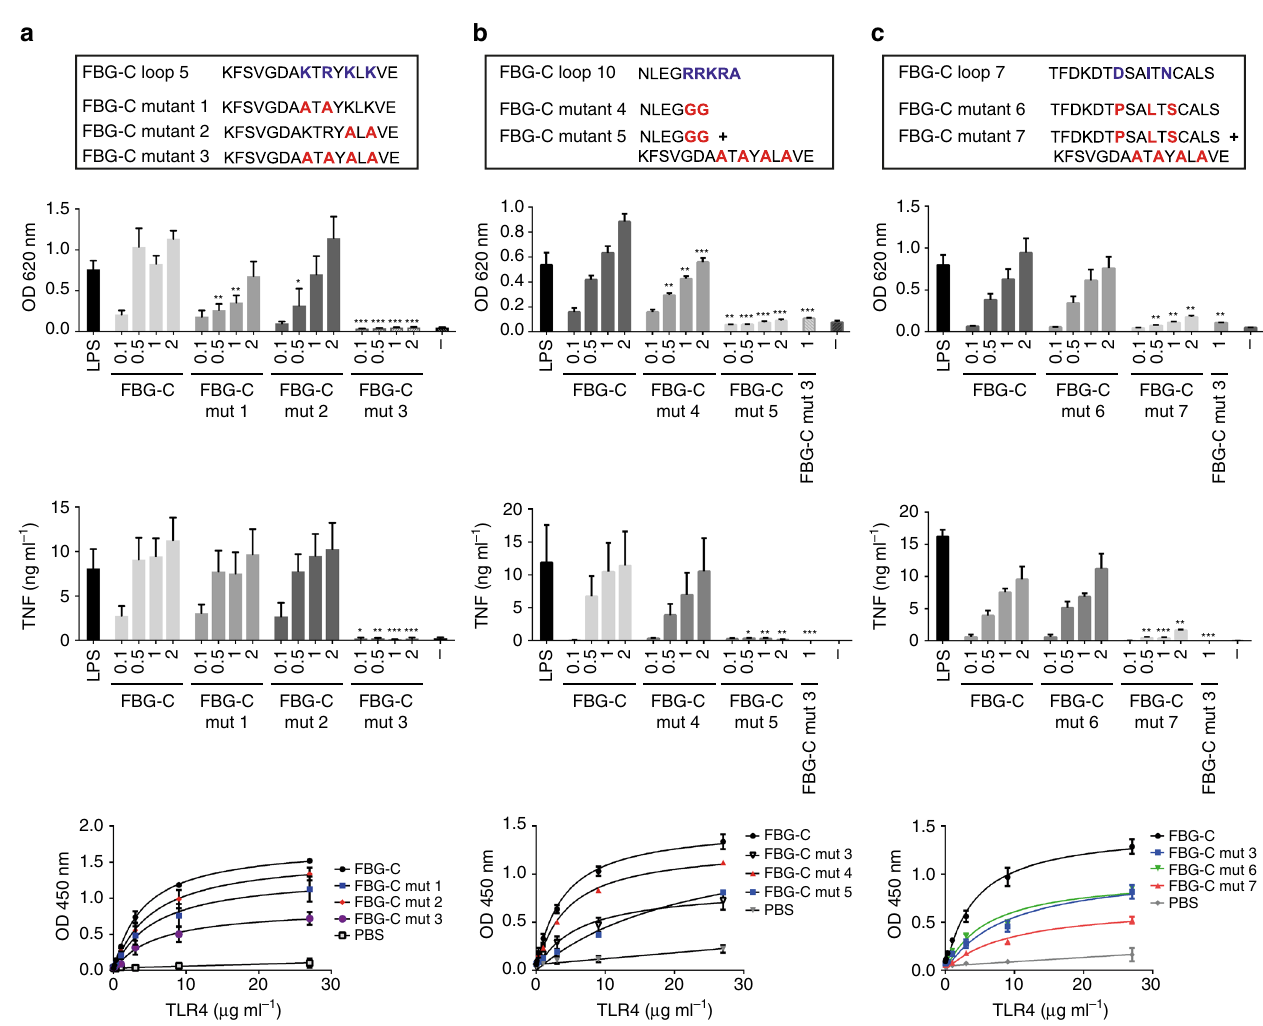
Fig. 4 Pinpointing amino acids in loops 5, 7, and 10 of FBG-C that mediate TLR4 binding and activation. Upper panel: Sequences of wild-type FBG-C and mutants 1 – 7, highlighting wild-type amino acids in blue and mutations in red (loop 5 variants are shown in a , loop 10 in b , and loop 7 in c ). Second panel: THP1 NF-kB cells were left unstimulated ( − ) or stimulated for 24 h with LPS (1 ng ml − 1 ), increasing doses ( μ M) of FBG-C or FBG-C mutants 1 – 7. NF-kB activation was measured using QUANTI-Blue ™ . Data shown as mean ± SEM. n = 4 independent experiments. Paired t -test vs. FBG-C, * p < 0.05, ** p < 0.01, *** p < 0.001. Third panel: Primary human macrophages were left unstimulated ( − ) or stimulated for 24 h with LPS (1 ng ml − 1 ), increasing doses ( μ M) of FBG-C or FBG-C mutants 1 – 7. Cytokines synthesis was measured by ELISA. Data shown as mean ± SEM. n = 4 independent donors. Paired t -test vs. FBG-C, * p < 0.05, ** p < 0.01, *** p < 0.001. Bottom panel: 96-well plates were coated with 1 µ g ml − 1 of FBG-C or FBG-C mutants 1 – 7, and TLR4 was added in